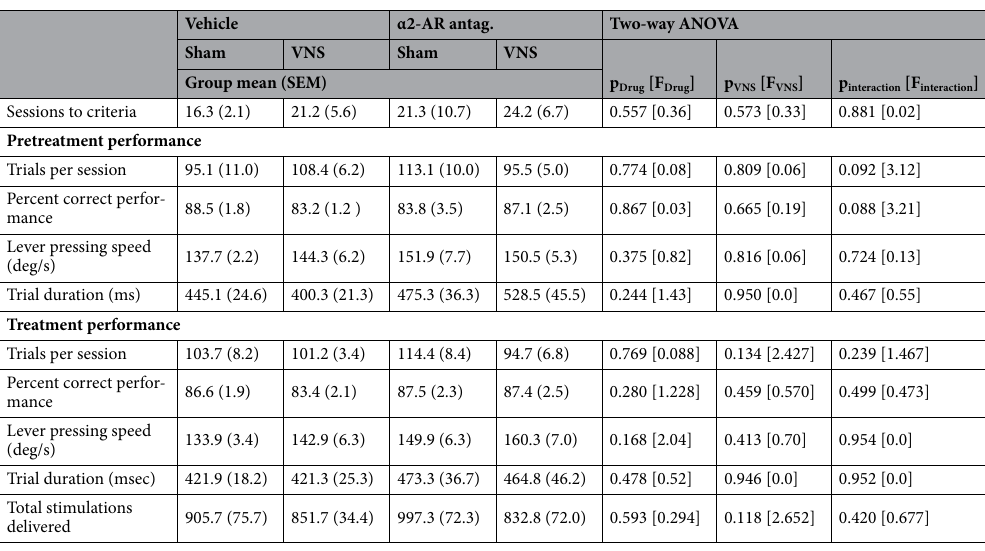
Table 2. Lever press behavior did not differ across treatment groups and was not impacted by VNS or α2-AR antagonist